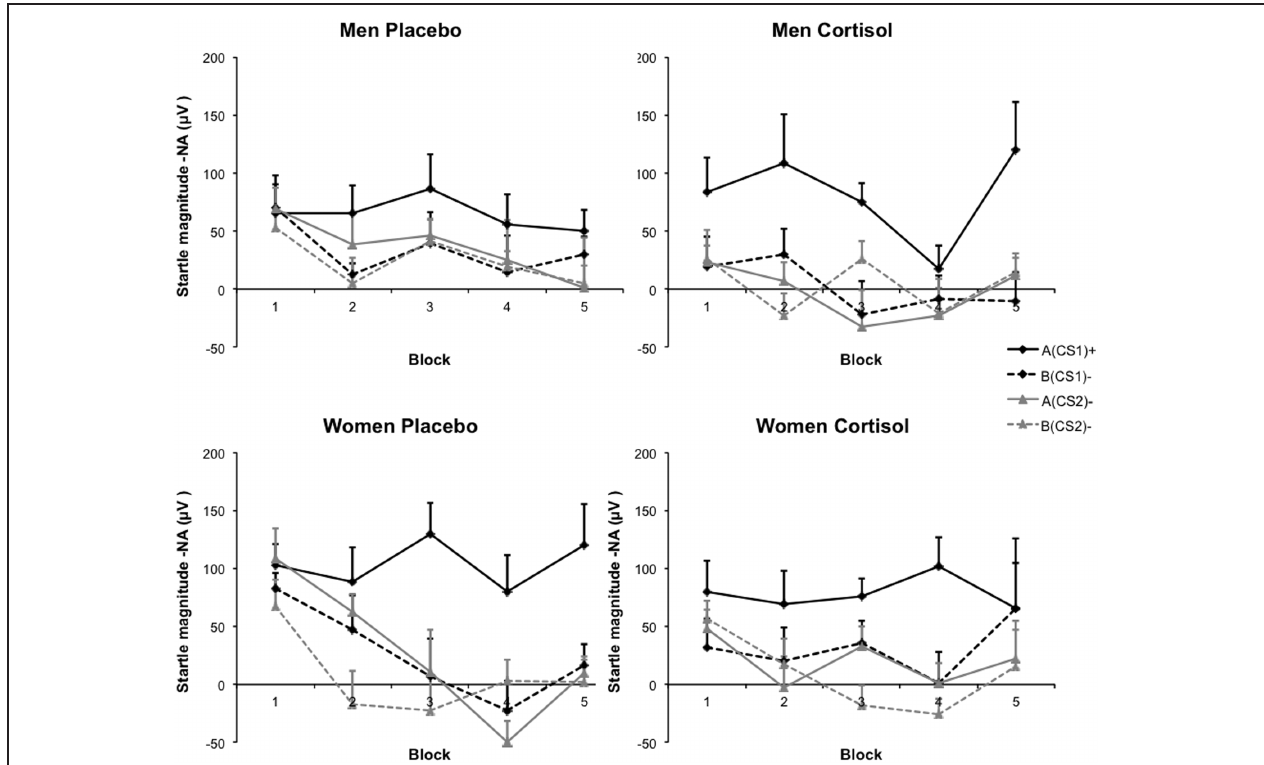
FIGURE 2 | Startle magnitudes. Averages of noise alone (NA) trials derived from the same block as the CS presentations were subtracted from average startle potentiation during CS presentations. Blocks